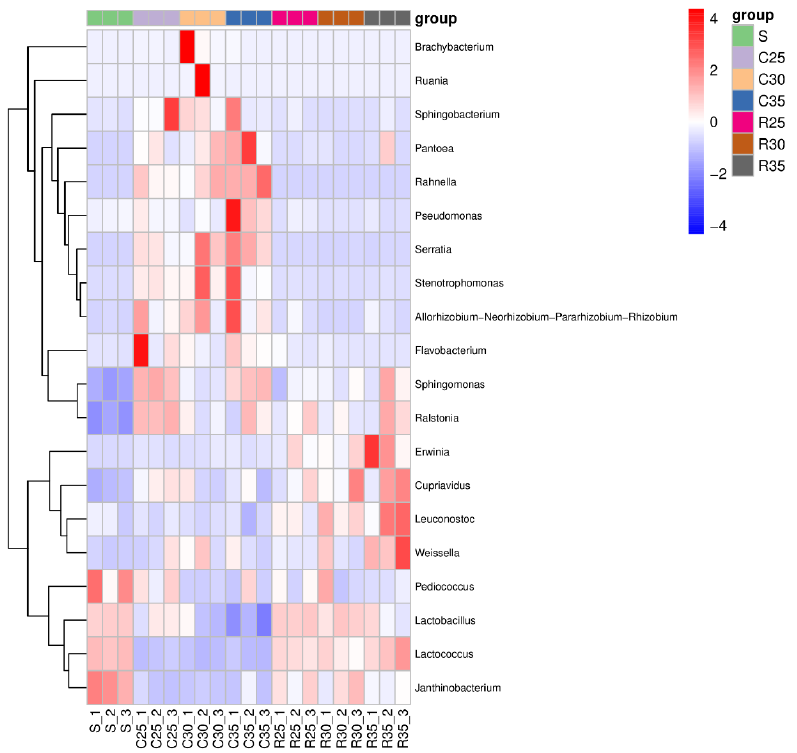
Figure 4. Heatmap analysis of the main bacterial community of corn stover or rice straw silage mixed with soybean curd residue (S, soybean curd residue; C35/R35, soybean curd residue: corn stover/rice straw at 65: 35; C30/R30, soybean curd residue: corn stover/rice straw at 70: 30; C25/R25, soybean curd residue: corn stover/rice straw at 75: 25).